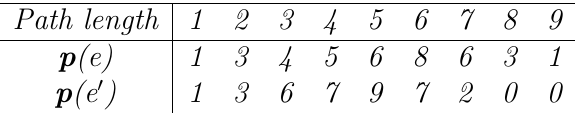
Figure 13: The tree 𝑇 ∗ .